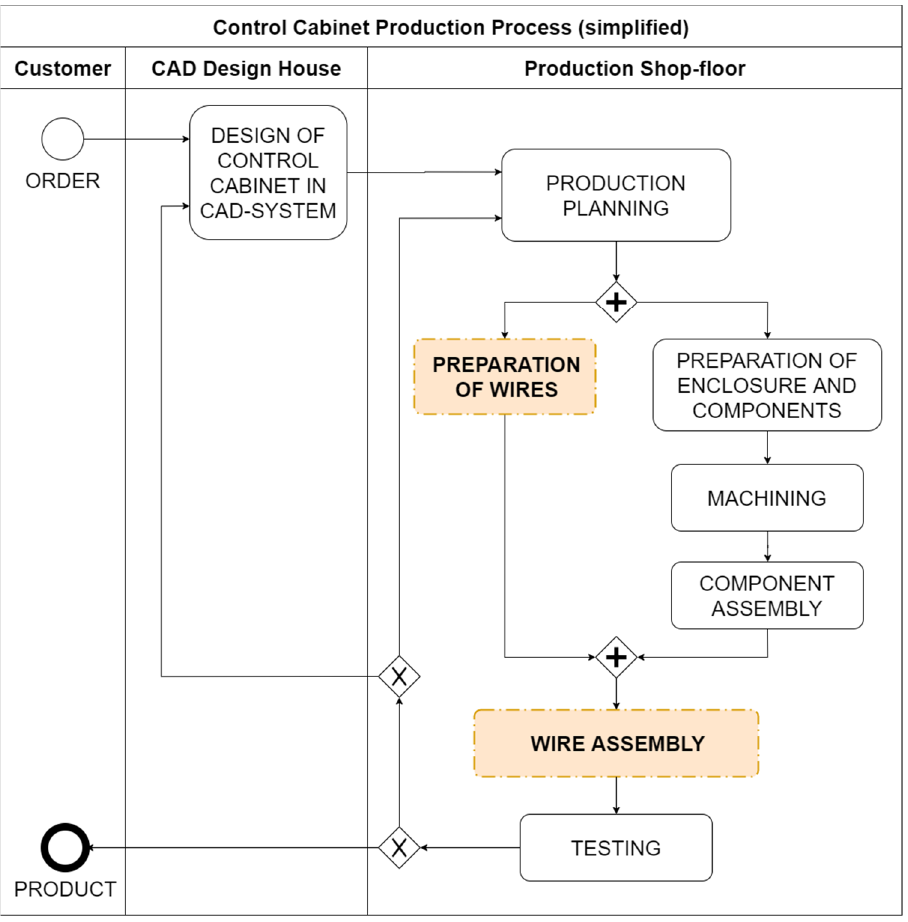
Figure 1. The main elements of the control cabinet production process. The orange background shows the production steps that are the focus of this paper.